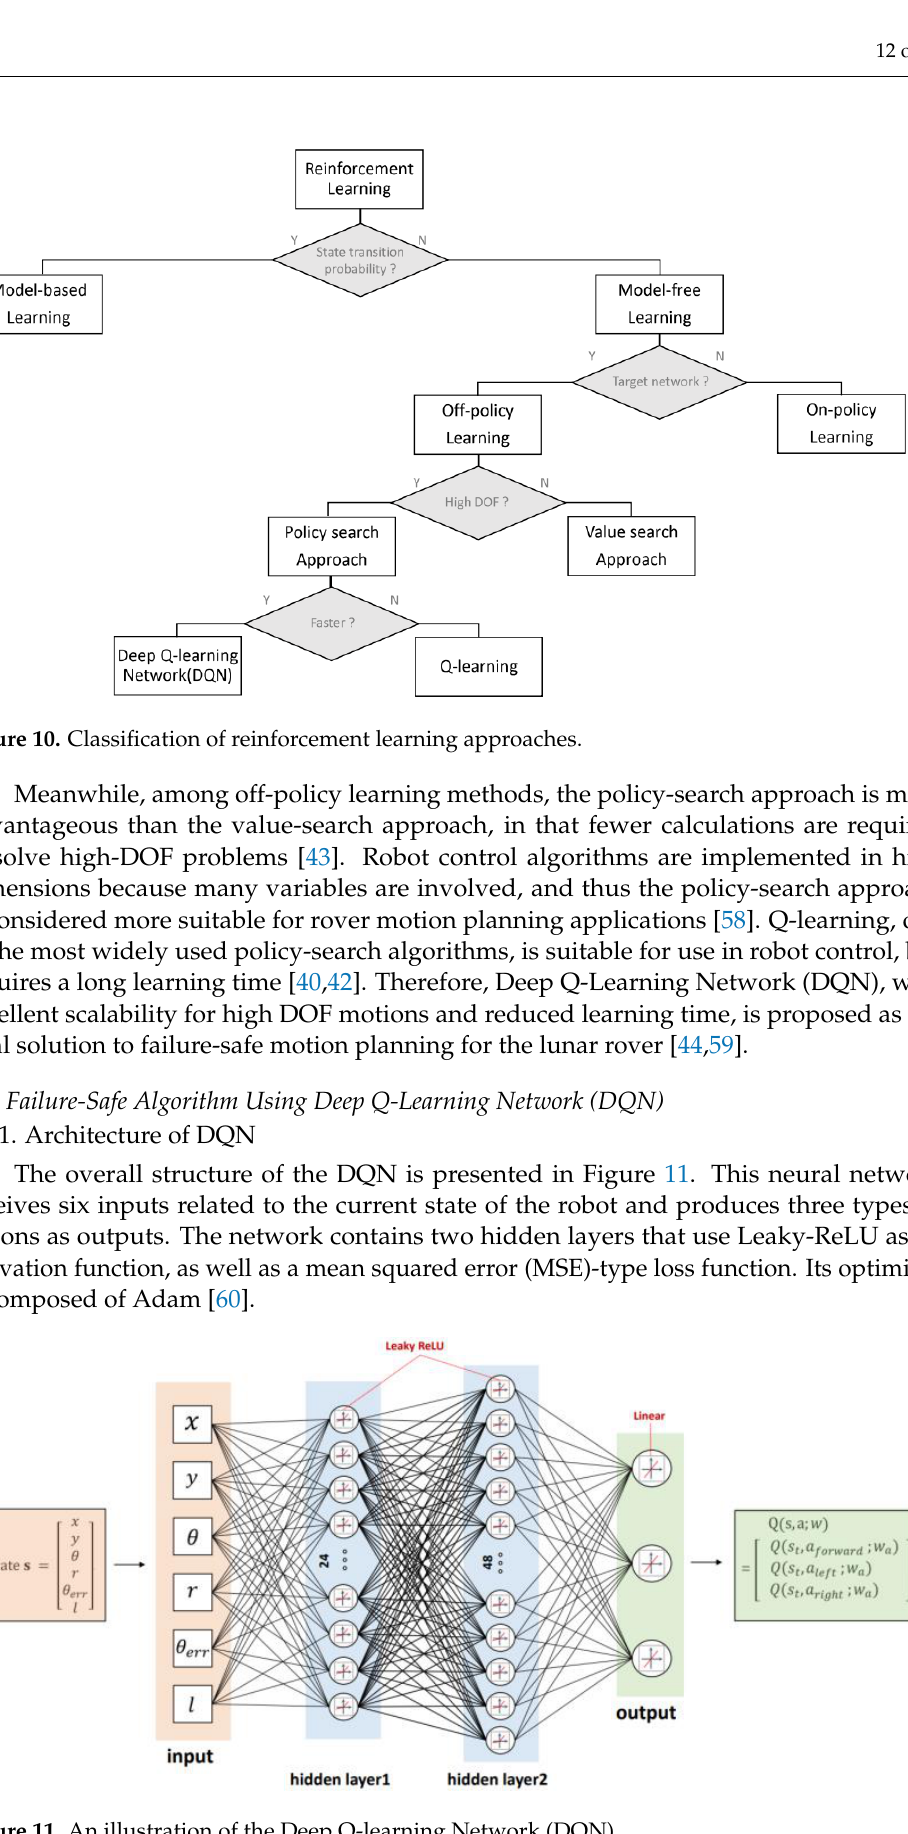
Figure 11. An illustration of the Deep Q-learning Network (DQN).